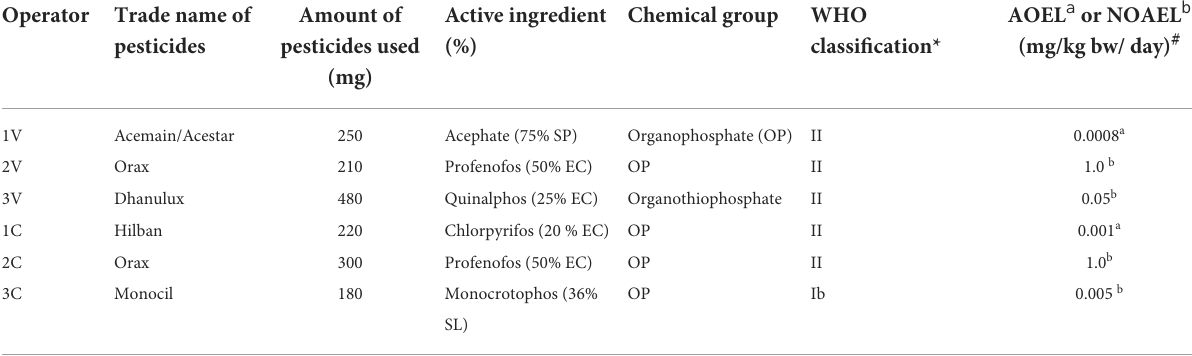
TABLE 1 Key information about the pesticides used by